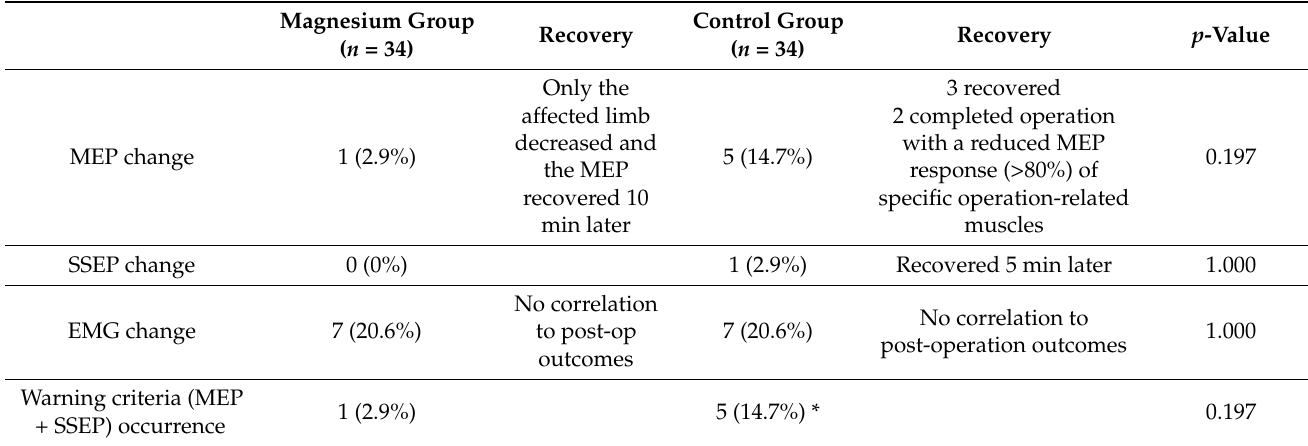
Table 3. Intraoperative neurophysiological monitoring